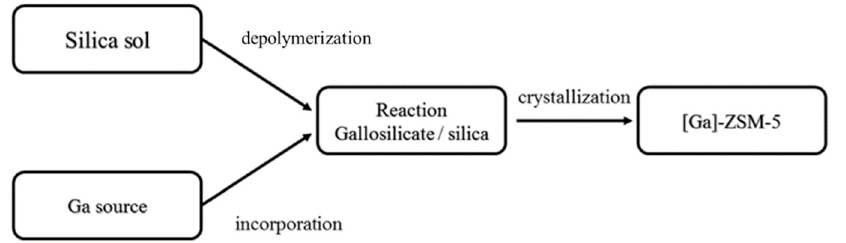
Figure 1. Hydrothermal synthesis process. Reprinted with permission from ref [59]. Copyright 1991 WILEY-VCH Verlag GmbH & Co. KGaA.